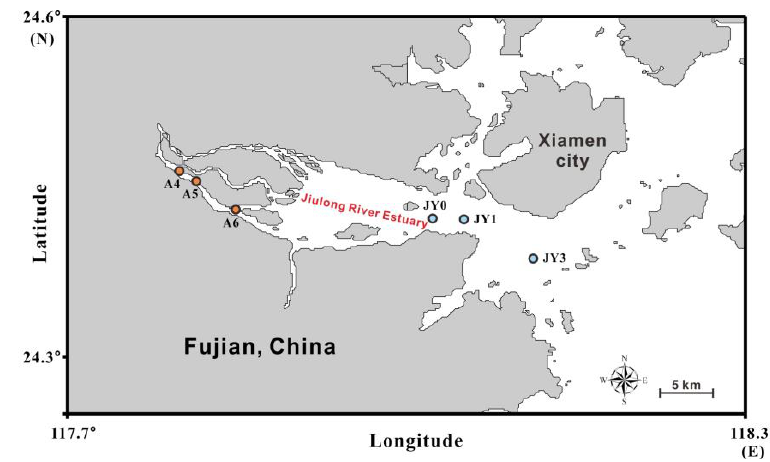
Figure 1. Study area map showing sediment sampling sites in Jiulong River Estuary (JRE).